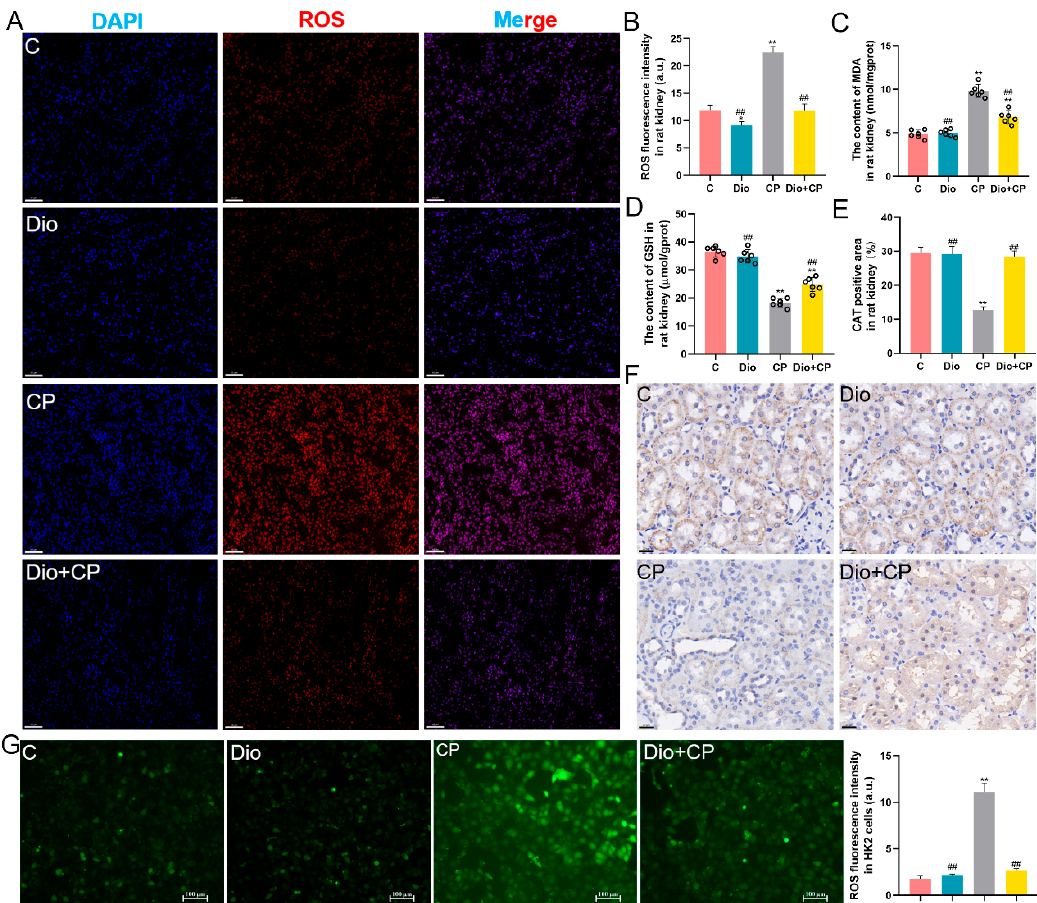
Figure 2. Dioscin ameliorates oxidative damage in rat kidneys and HK2 cells. ( A , B ) Representative images (scale bar = 50 μ m) and quantification of ROS (red) in rat kidney tissue (n = 5). ( C , D ) Levels of MDA and GSH in rat kidney tissue (n = 6). ( E , F ) Representative images (scale bar = 20 μ m) and quantification of CAT immunohistochemistry in rat kidney (n = 5). ( G ) Representative images (scale bar = 100 μ m) and quantification of ROS (green) in HK2 cells (n = 5). C, control group; Dio, dioscin group; CP, cisplatin group; Dio + CP, dioscin + cisplatin group. Results are presented as Mean ± SD. Statistical significance was obtained by one-way ANOVA. ** p < 0.01 compared with C group. ## p < 0.01 compared with CP group.